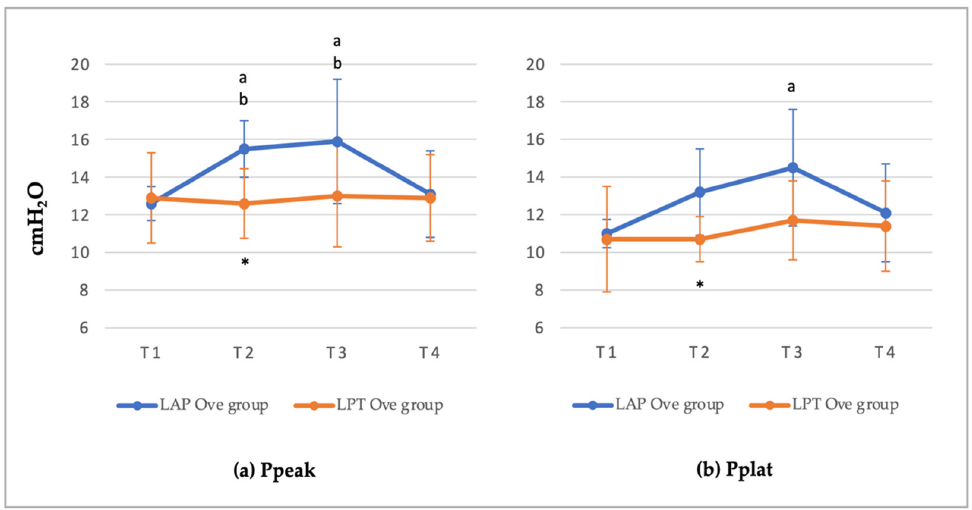
Figure 1. ( a ) Peak inspiratory pressure (Ppeak) and ( b ) Plateau pressure (Pplat) values determined at different points in time along the experimental period. Values given as a mean ± SD. p < 0.05: * vs. the LAP Ove group at the same time; a vs. T1 and b vs. T4 within the same Ove group.